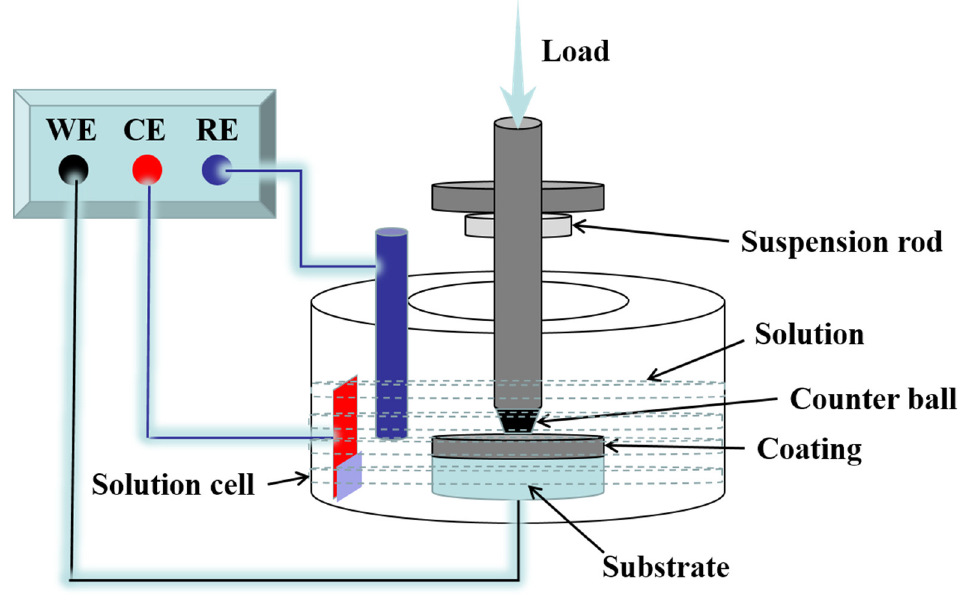
Figure 1. Reciprocating ball-on-disc tribometer schematic diagram.